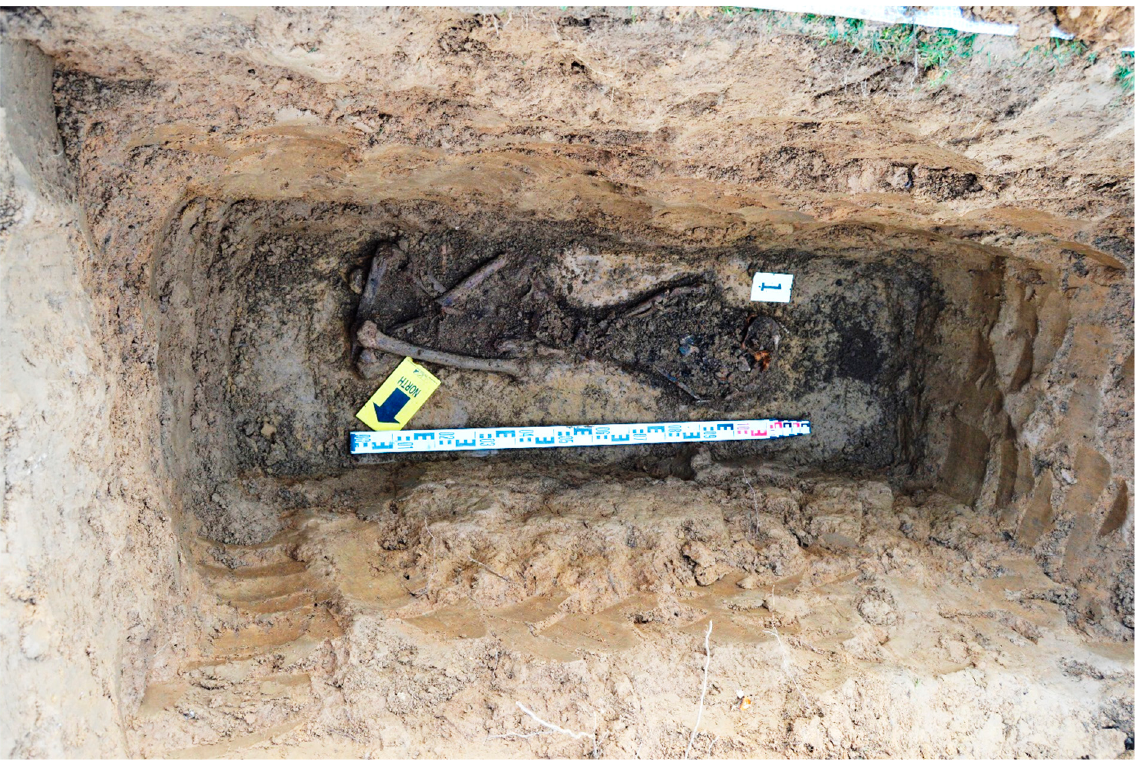
Figure 2. A grave cavity with the remains of an identified man at the Polish War Cemetery in Grainville-Langannerie.